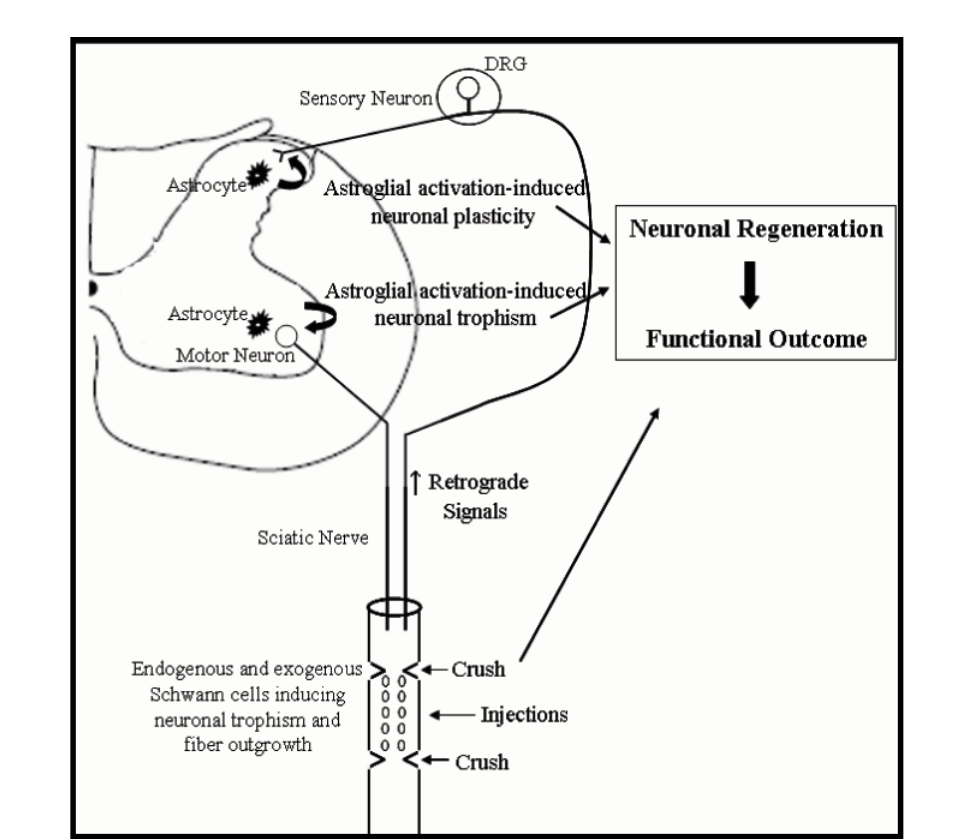
FIGURE 6 - The scheme shows the reaction of astrocytes in the spinal cord dorsal horn, close to central projections of peripheral sensory neurons, and in the ventral horn, close to perikarya of peripheral motor neurons, after a unilateral contiguous double crush leading the formation of a reservoir (5mm long) in the rat sciatic nerve used to local inoculations performed in this work. The proximal crush led to Wallerian degeneration in the sciatic nerve, triggering retrograde signals capable to activate spinal cord astrocytes. Schwann cells in the wound regions become also activated favoring local trophism and fi bber outgrowth. The responses of reactive astrocytes in the dorsal and ventral horns after axotomy may be related to different mechanisms, for instance, to neuronal plasticity and neuronal trophism, respectively. Neuronal plasticity at dorsal horn may interfere with local neurotransmission, leading to formation of neuropathic pain. Neuronal trophism in the ventral horn may induce neuronal maintenance. Taken all together, the events in fl uence wound/repair and neuronal regeneration and the functional outcome. Those processes that are taken place after axotomy might be in fl uenced by the type of the lesion and the method applied for nerve repair, as seen by the